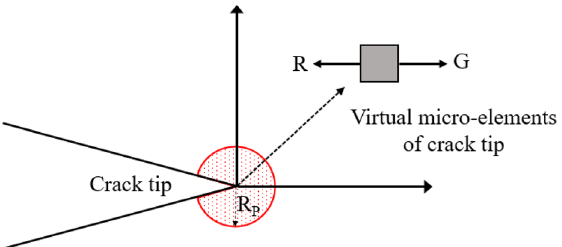
Figure 8. The schematic diagram of virtual micro element at crack tip (R p is the radius of the plastic zone determined based on the von Mises yield criterion, R is fracture toughness, and G is stress intensity